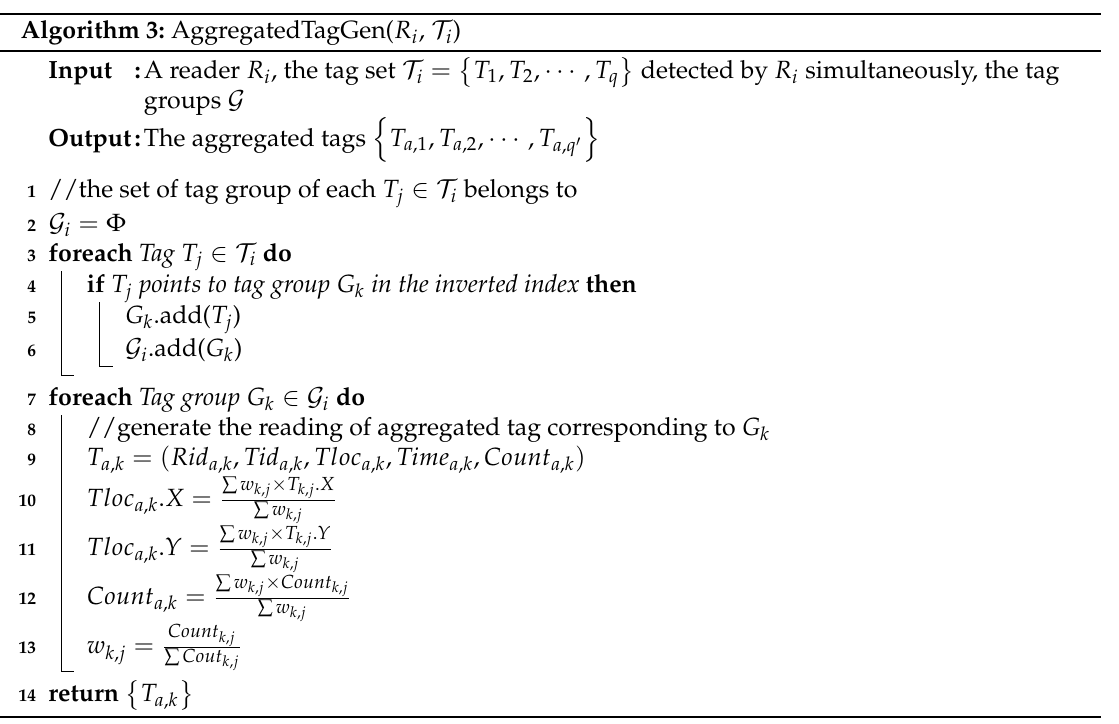
Algorithm 3: AggregatedTagGen( R i , T i )